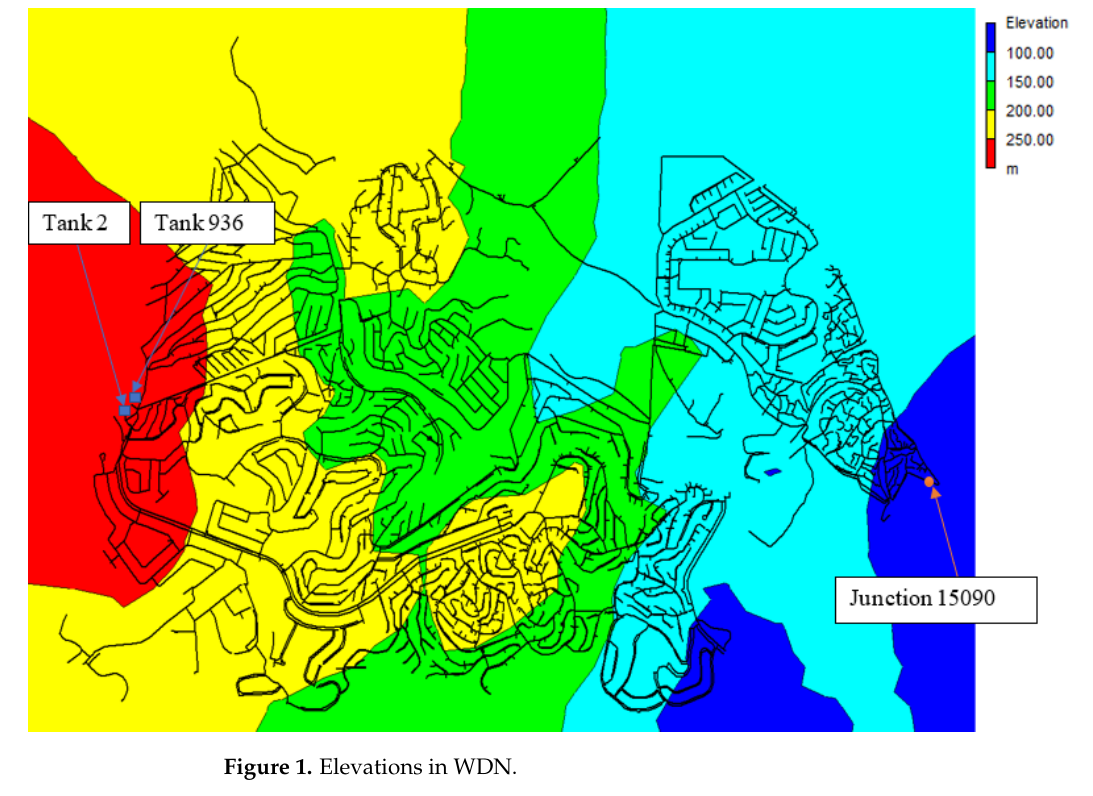
Figure 1. Elevations in WDN.